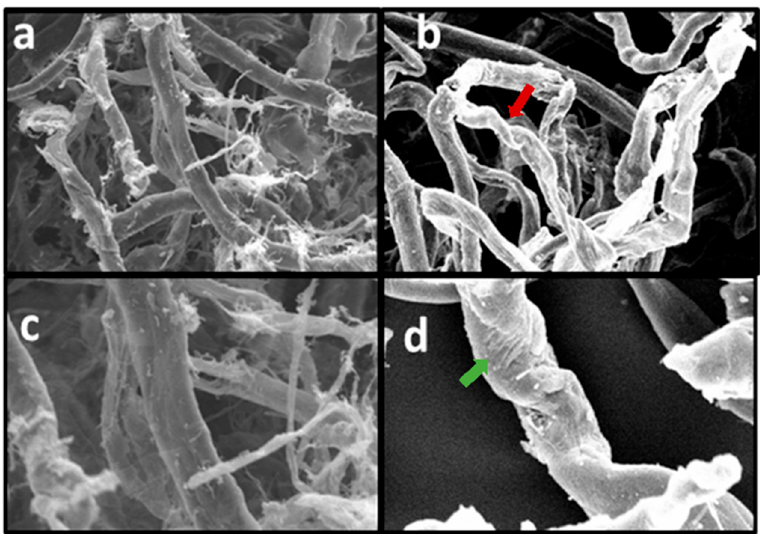
Figure 6. SEM images of CLC sample before mercerization treatment at 400 × magnification ( a ), 1000X magnification ( c ) and after mercerization treatment at 400 × magnification ( b ) and 1000 × magnification ( d ).